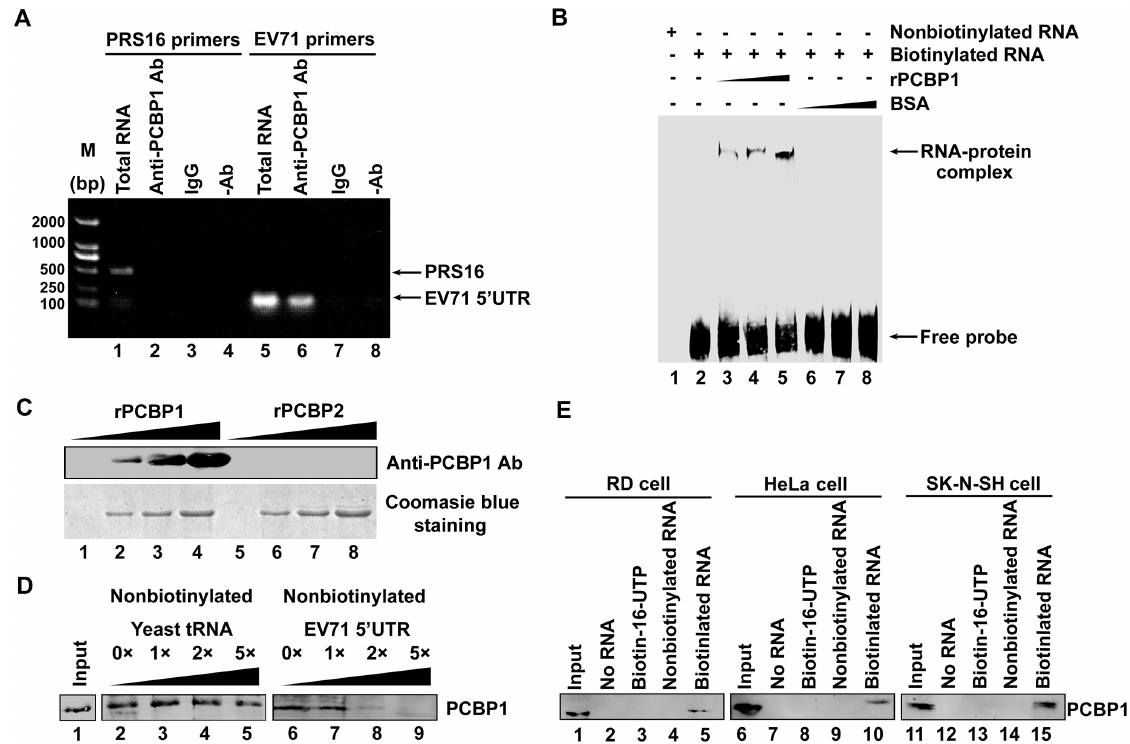
Figure 1. Interaction between PCBP1 protein and the 5 9 UTR of EV71 RNA. (A) Co-immunoprecipitation (Co-IP) and RT-PCR assay. RD cells were infected with EV71 at an MOI of 40 for 6 h and then cell extracts were prepared. For Co-IP assay, extract of EV71-infected cells was incubated with mouse anti-PCBP1 antibody (lanes 2 and 6), normal mouse IgG (lanes 3 and 7), or without antibody (-Ab) (lanes 4 and 8). Following washing and dissociation, the RNA extract was prepared and subjected to RT-PCR analysis with primers specific for the ribosomal protein S16 (PRS16) RNA (lanes 1–4) or for EV71 5 9 UTR RNA (lanes 5–8). Total RNA from cell extracts without Co-IP was evaluated by RT-PCR as a control (lanes 1 and 5). RT-PCR products were separated and detected by agarose gel electrophoresis and the expected band is indicated by an arrow. (B) Electrophoretic mobility shift assay (EMSA). Plasmid carrying EV71 5 9 UTR DNA was linearized and in vitro transcribed into RNA, which was then labeled with biotin-16-UTP at the 3 9 end. Labeled RNA (0.5 m g) was incubated with recombinant PCBP1 (rPCBP1) at 0, 0.1, 0.15 and 0.2 m g (lanes 2 to 5) or BSA at 0.1, 0.15, and 0.2 m g (lanes 6 to 8), respectively. The RNA-protein complex (indicated by an arrow) was separated from free probe RNA and examined by EMSA. No- labeled RNA was in lane 1 as a control. (C) The specificity of the PCBP1 antibody. Purified rPCBP1 protein (lanes 1 to 4) and rPCBP2 protein (lanes 5 to 8) were subjected to SDS-PAGE at 0, 2, 4 and 8 m g, respectively, stained by Coomasie blue and then detected by specific PCBP1 antibody. (D) Biotinylated RNA/protein pull-down assays. For RNA/protein pull-down assay and for competition assay, cell extracts were mixed with biotinylated EV71 5 9 UTR RNA (lanes 2–9) along with different concentrations of nonbiotinylated yeast tRNA (lanes 2–5) or nonbiotinylated EV71 5 9 UTR RNA (lanes 6–9), respectively. After pull-down assay, the bound proteins were boiled and subjected to 12% SDS-PAGE and analyzed by western blotting with a mouse anti-PCBP1 antibody. The input contained 200 m g cell lysate (lane 1). (E) Extracts of RD cells (lanes 1–5), HeLa cells (lanes 6–10), and SK-N-SH cells (lanes 11–15) were prepared and then incubated without RNA (lanes 2, 7, and 12), with biotin-16-UTP (lanes 3, 8, and 13), non-biotinylated EV71 5 9 UTR (lanes 4, 9, and 14), or biotinylated EV71 5 9 UTR (lanes 5, 10, and 15). After pull-down assay, the bound proteins were boiled, eluted, and subjected to 12% SDS-PAGE and PCBP1 protein was detected by western blot with a mouse anti-PCBP1 antibody. The inputs were cell extracts of RD (lane 1), HeLa (lane 6), and SK-N-SH (lane 11). The ability of PCBP1 protein binds to the 5 9 UTR of EV71 was further determined by electrophoretic mobility shift assay (EMSA). Labeled EV71 5 9 -UTR RNA (nt 1–745) was incubated with purified PCBP1 protein (0.1, 0.15, and 0.2 m g) or BSA (0.1, 0.15,